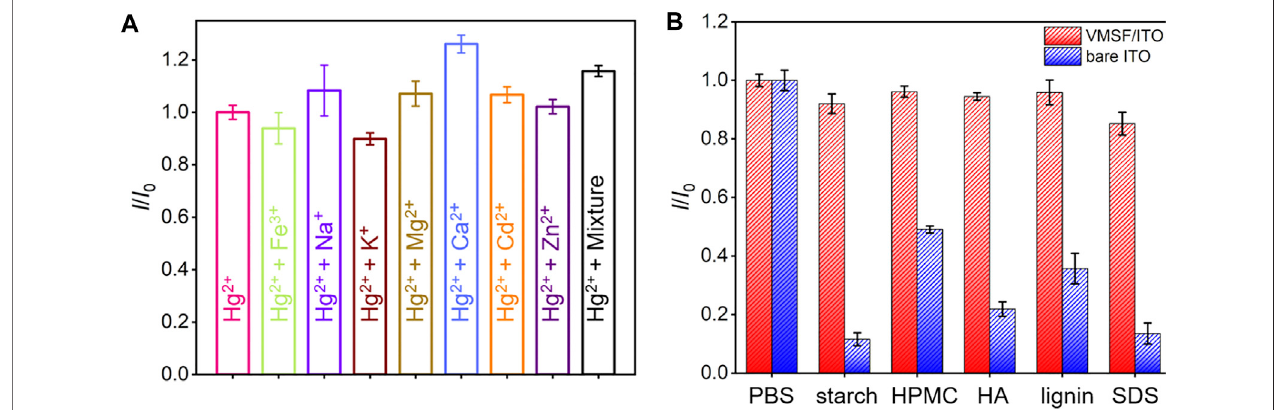
FIGURE 6 | (A) The current ratio ( I / I 0 ) obtained from the VMSF/ITO electrode for the detection of 1 μ M Hg 2+ in the absence ( I 0 ) and presence ( I ) of 100 μ M different metal ions. (B) Comparison ofthe I / I 0 obtained from the VMSF/ITOand bare ITO electrode for the detection of1 μ M Hg 2+ in theabsence( I 0 ) and presence ( I ) of complex interfering species (50 μ g/ml starch, HPMC, HA, Lignin and SDS). The error bars represent the SD of three measurements.